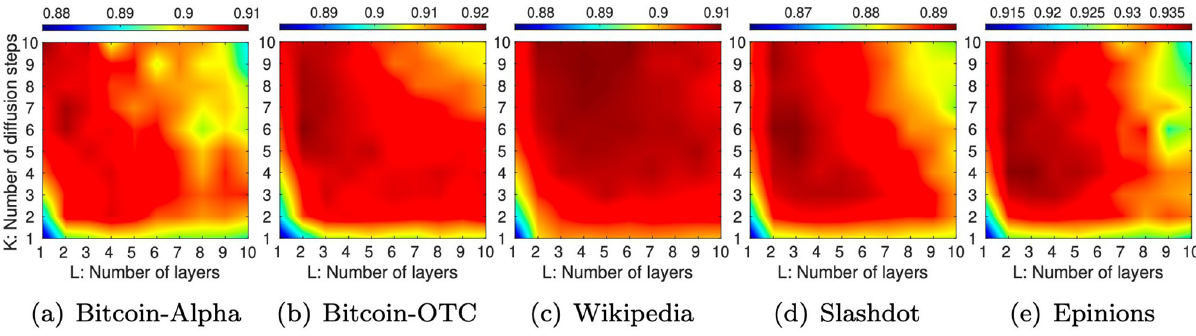
Fig 5. Effect of propagation hops of S ID N ET in terms of AUC where S ID N ET performs K × L -hop feature propagations. Overall, the accuracy becomes better by setting K and L such that 20 � K × L (hop count) � 30 while S ID N ET with a small hop count exhibits poor results over all datasets.